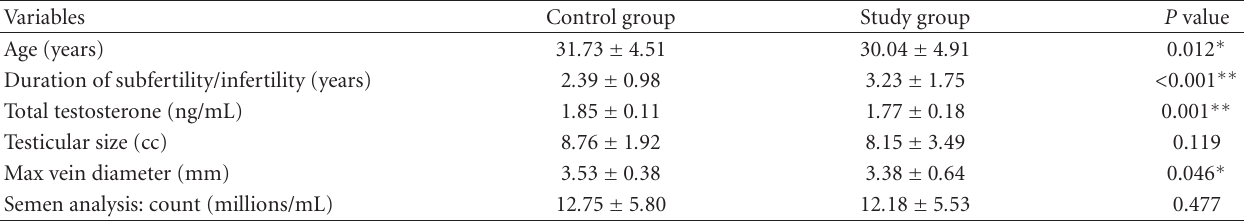
Table 6: Comparisons of age, infertility duration, testicular size, maximum vein diameter, sperm count, total testosterone pre- procedure between the study group and control group.